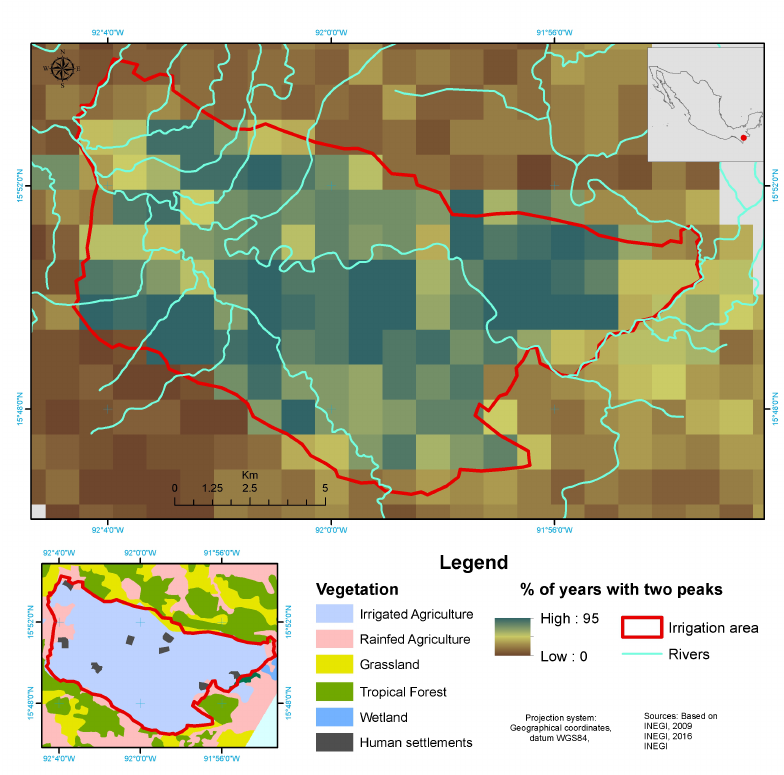
Figure 8. Spatial distribution of the ratio (percentage) of the amount of years with two peaks per year to the total amount of years studied in Santo Domingo,